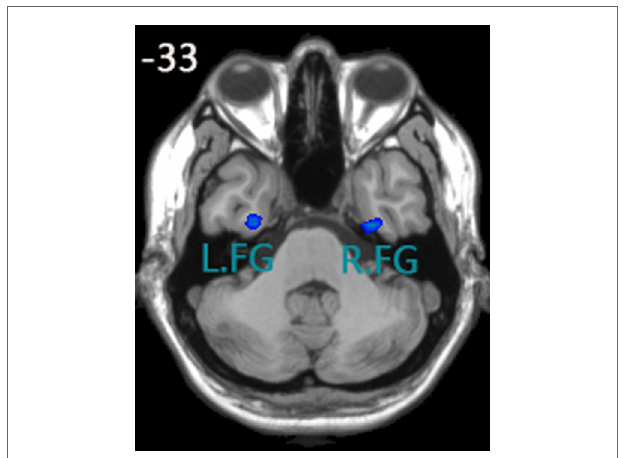
FigUre 1 | seed regions of the left Fg and right Fg; (1) x , y , z coordinates of primary peak locations in the space of MNI of the left FG are −28, −9, −38; t = −2.731; volume: 1836 mm 3 . (2) x , y , z coordinates of primary peak locations in the space of MNI of the right FG are 32, − 10, − 38; t = − 2.935;volume: 2403 mm 3